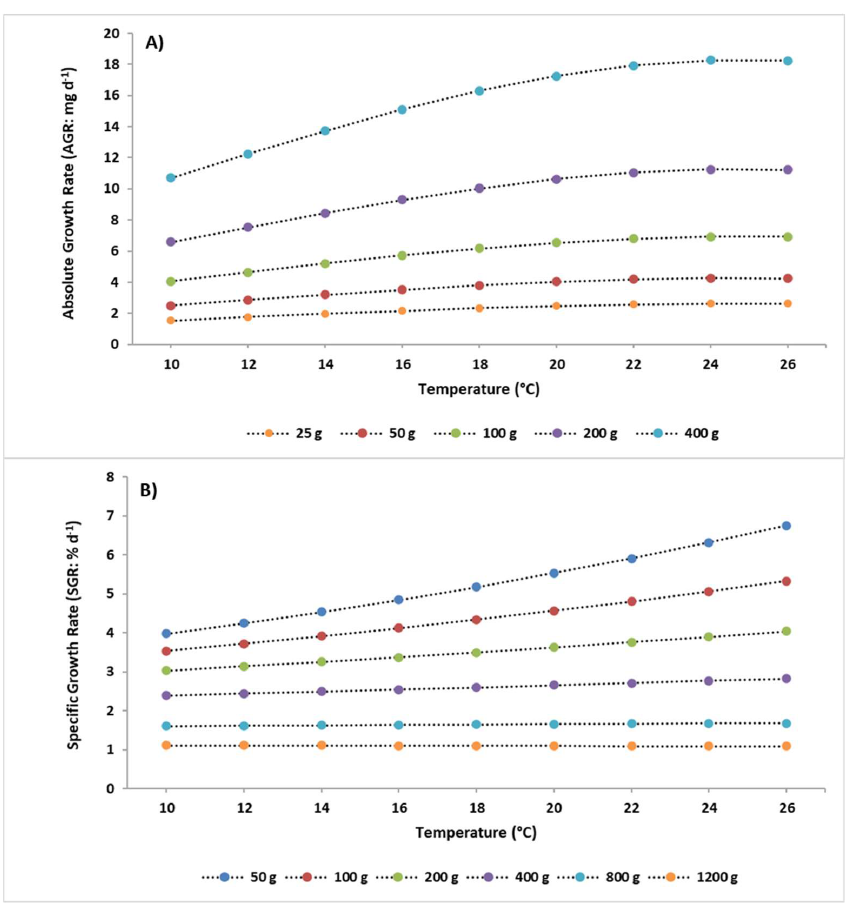
Figure 4. ( A ) Estimation of AGR (Equation (2)) for individuals weighing less than 400 mg and ( B ) estimation of SGR (Equation (9)) for individuals in the full range of observed weight at differ‑ ent temperatures within the range of observed temperatures.